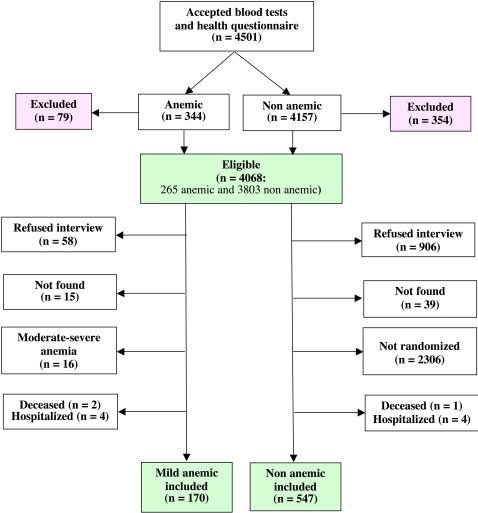
Flow chart of the study.